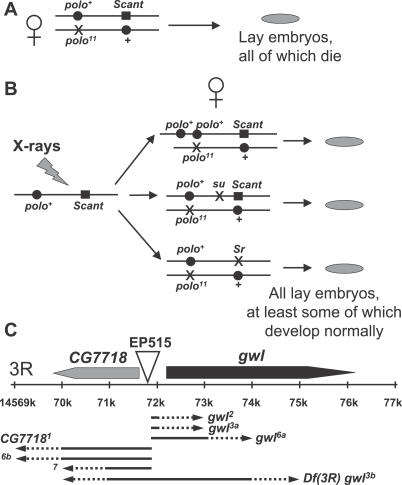
Generation of gwl Alleles(A) Females heterozygous for both the Scant mutation and a loss-of-function polo mutation (such as polo11) lay embryos that die during development.(B) Genetic screen to generate Scant revertant (Sr) alleles. Males homozygous for Scant were x-rayed and crossed to polo11 heterozygous females. Female progeny were tested for fertility. Scant revertant mutations restore female fertility and can be duplications of the polo+ gene, third-site suppressor mutations (su), or recessive mutations allelic to each other. See Text S1 for details.(C) Hopping a P-element inserted directly upstream of the gwl gene generated imprecise excisions disrupting either gwl (gwl2, gwl3a, and gwl6a), CG7718 (CG77181, CG77186b, and CG77187) or both genes (gwl3b). gwl2, gwl3a, and gwl6a are semilethal and produce a “Scant-revertant (Sr) phenotype” when placed over Sr alleles (generated in [B]). The extent of the imprecise excisions was approximately mapped by the ability to PCR-amplify the 1 kb-long regions of genomic DNA defined by the tick marks.